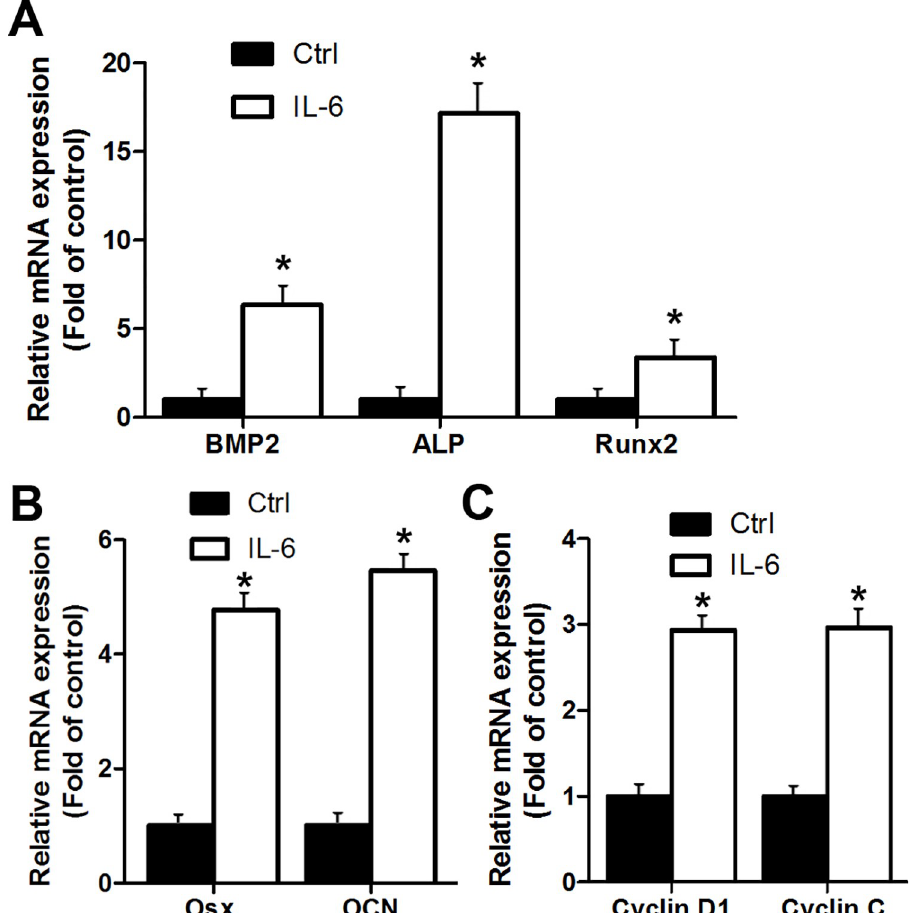
determined via qRT-PCR in ligamentum flavum cells with (IL-6) or without (Ctrl) IL-6 stimulation; (B) Effect of IL-6 on expressions of osteoblastic factors OSX and OCN. Gene expressions were determined via qRT-PCR in ligamentum flavum cells with (IL-6) or without (Ctrl) IL-6 stimulation; (C) Effect of IL-6 on expressions of cell proliferation factors cyclin D1 and cyclin C. Gene expressions were determined via qRT-PCR in ligamentum flavum cells with (IL-6) or without (Ctrl) IL-6